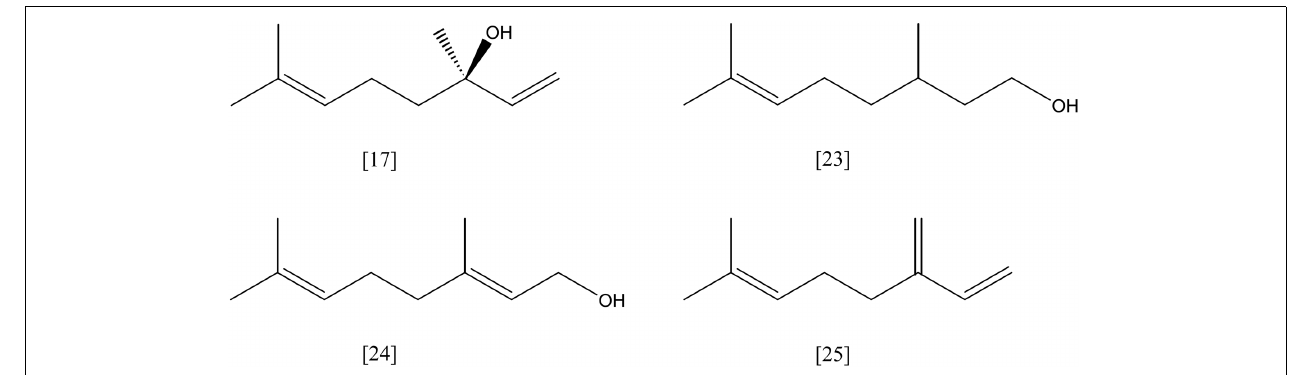
FIGURE 8 | ( S )-( + )-linalool [17]; citronellol [23]; geraniol [24]; β -myrcene [25].